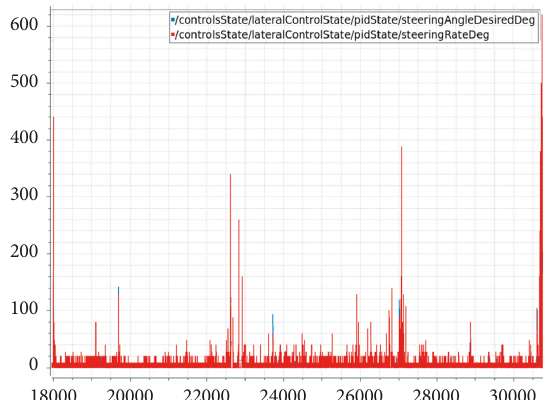
Figure 55: T2N1 steering